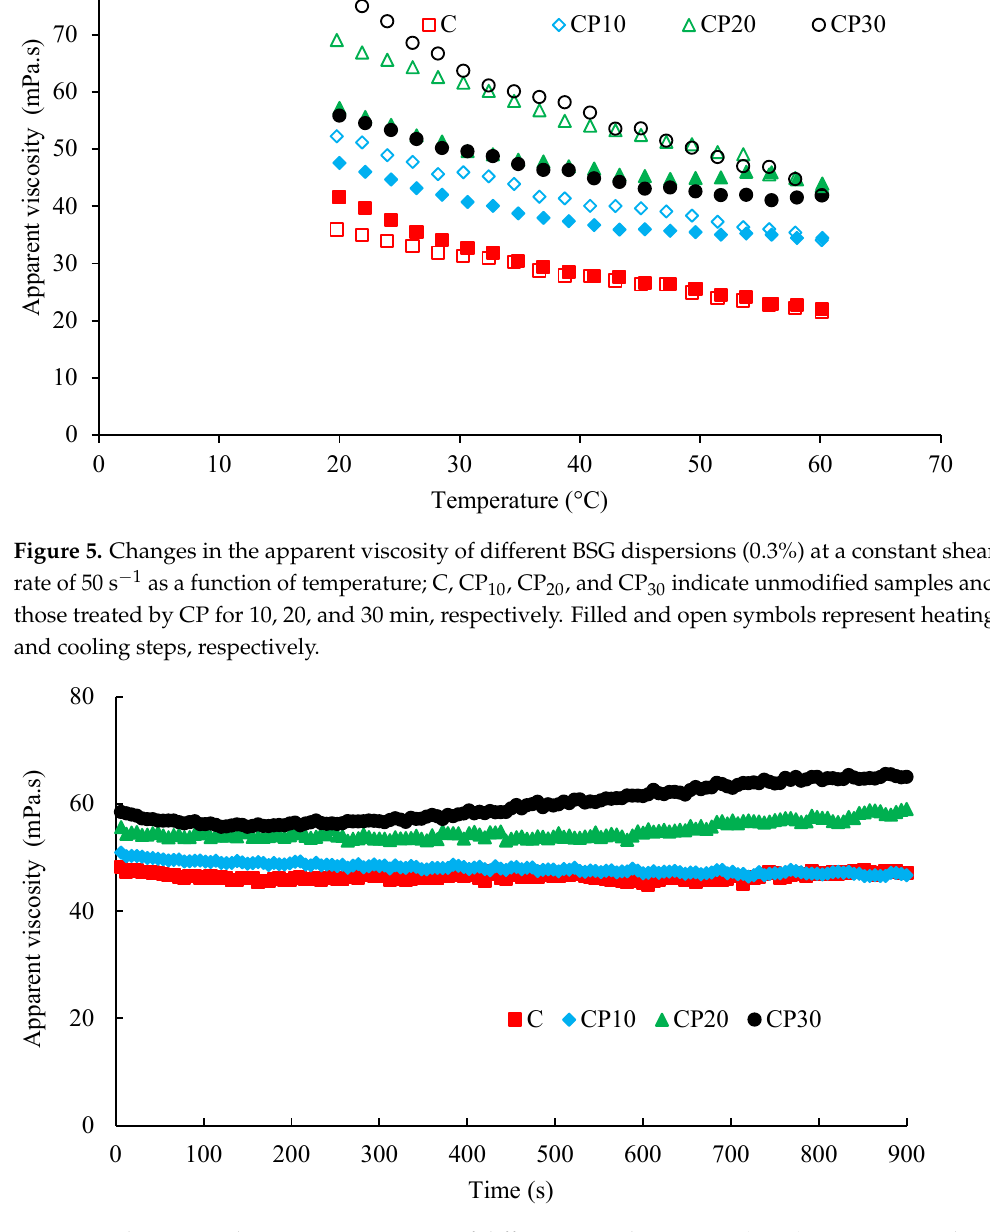
Figure 6. Changes in the apparent viscosity of different BSG dispersions (0.3%) at a constant shear rate of 50 s − 1 as a function of time; C, CP 10 , CP 20 , and CP 30 indicate unmodified samples and those treated by CP for 10, 20, and 30 min, respectively.